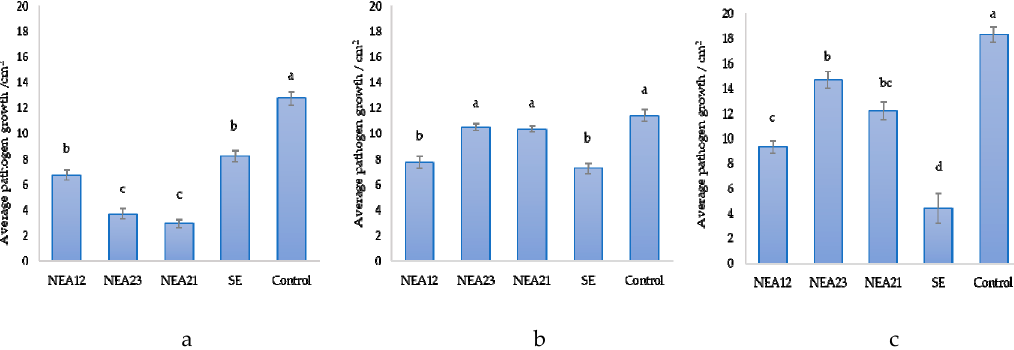
Figure 2. The Epichloë spp. endophyte strains NEA12, NEA23, NEA21, and SE show inhibitory activity against ( a ) Ceratobasidium sp., ( b ) Fusarium sp., and ( c ) Drechslera sp. The control in each graph is the pathogen alone. Image analysis was used to measure growth area (cm 2 ) of the pathogen on day 5 of the dual culture assays. All data are mean ± standard error, n = 5. Means that do not share a letter are significantly di ff erent. Significance was determined by one-way ANOVA and Tukey post-hoc test for pairwise comparison; p < 0.01 indicates significant inhibition di ff erence between assay results.